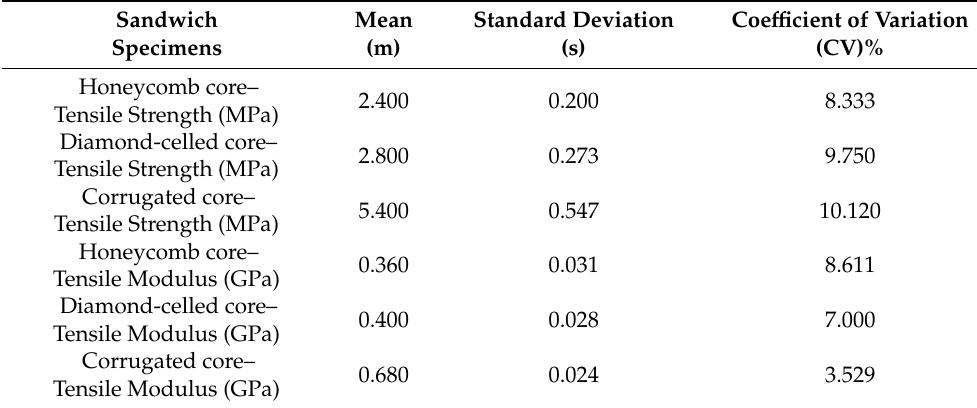
Table 7. Statistical parameters determined from the tensile tests of sandwich specimens.